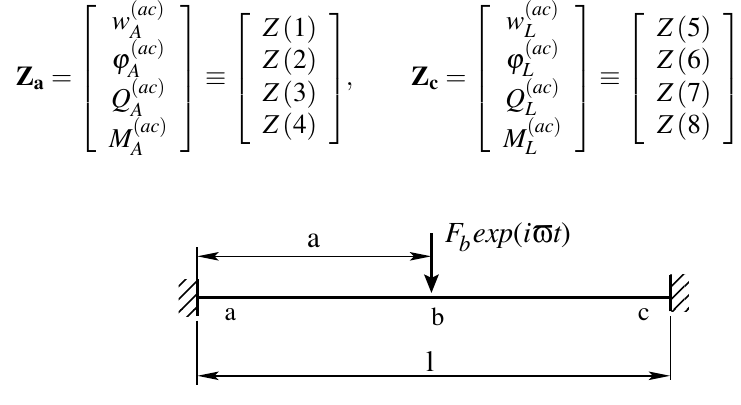
Fig. 4. Fixed-fixed beam. Fig. 4. Fixed­fixed